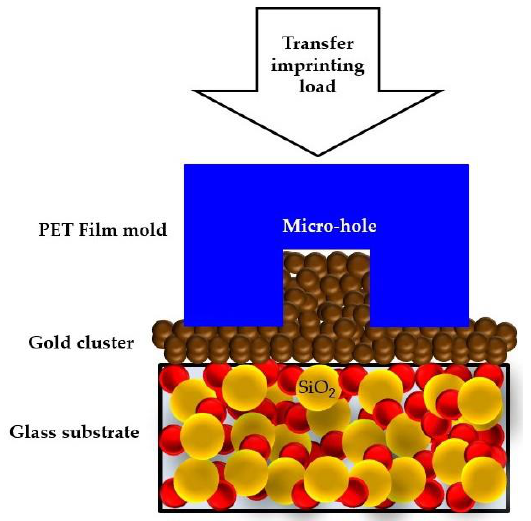
Figure 10. The schematic diagram of the compression mechanism for the transfer imprinting pro-